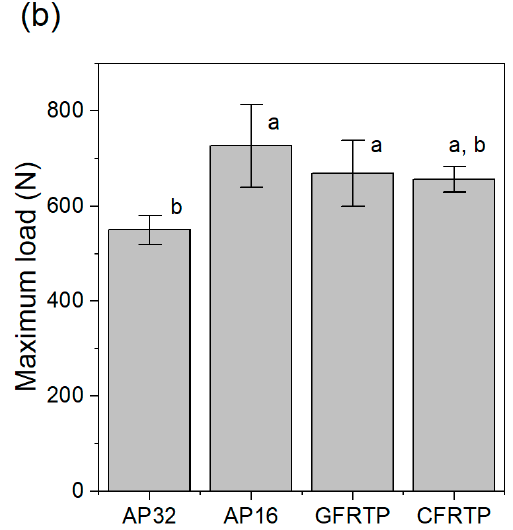
Figure 3. ( a ) Load obtained from shock absorption of AP16. ( b ) Maximum loads of AP32, AP16, GFRTP, and CFRTP. Bars labeled with the same letter show no significant difference ( p > 0.05).